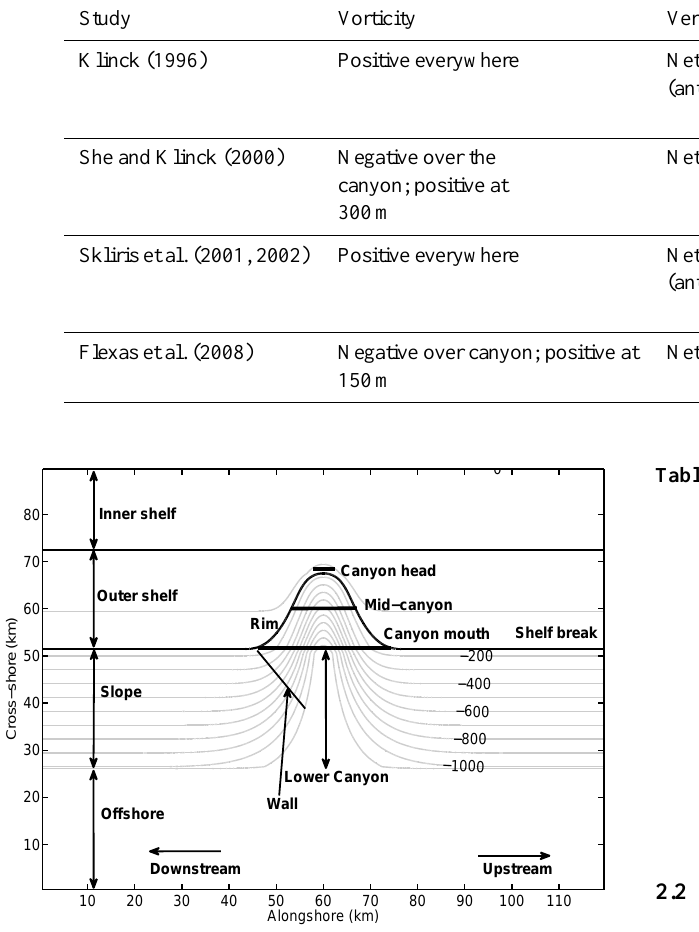
Figure 1. Canyon bathymetry (grey lines) and reference termin- ology used in this thesis. Canyon rim indicates the boundary be- tween the continental shelf and the canyon. Shelf break indicates change in slope gradient between the continental shelf and slope. Canyon mouth is the open region along the shelf break, canyon head is the shallowest onshore canyon region, mid-canyon is the region between the canyon head and mouth, and lower canyon is offshore of the canyon mouth. Canyon wall refers to canyon topography be- tween shelf break and bottom depth. Zonal flow is in the alongshore direction, and meridional flow is in the cross-shore direction. Con- tour intervals are 100m.